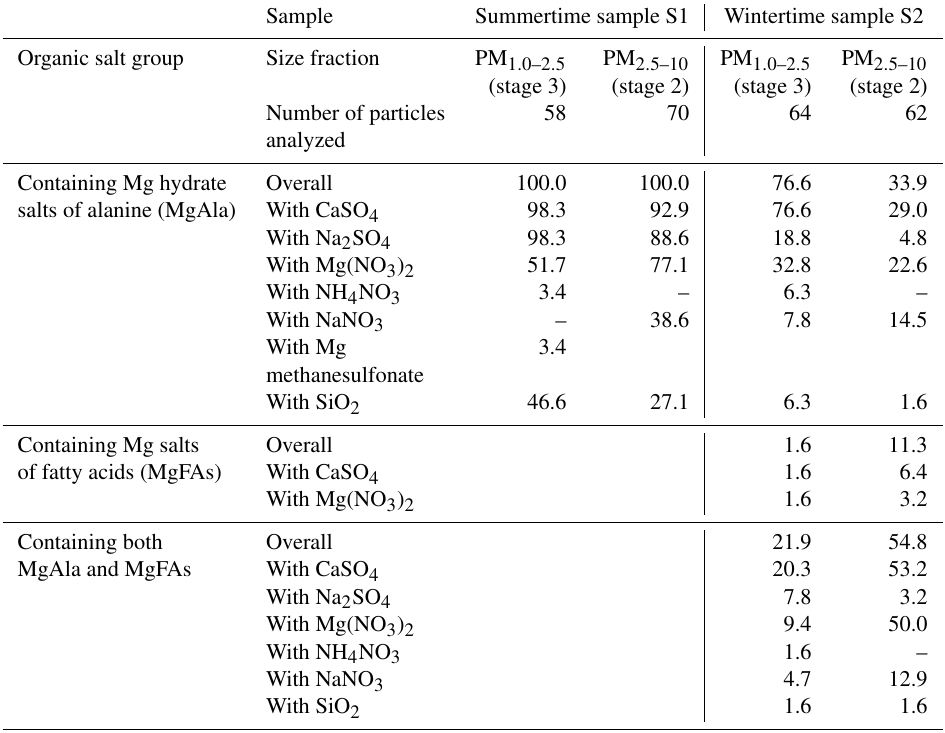
Table 2. Relative encountering frequencies (in %) of the organic and inorganic species of individual summertime and wintertime